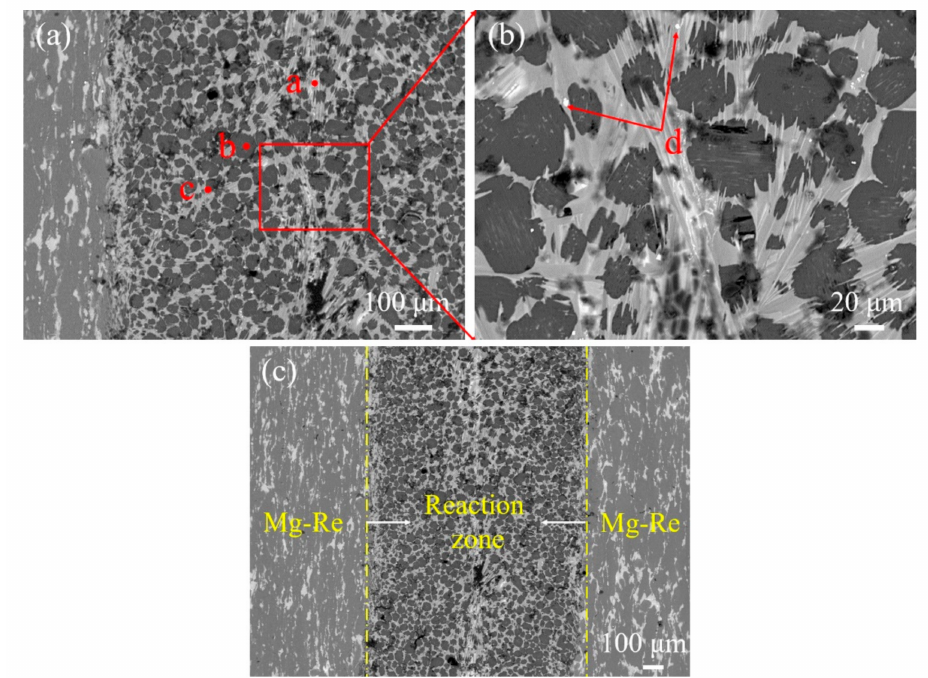
Figure 5. Microstructure of diffusion bonding joint at 440 ◦ C, 1500# for 30 min under 2 MPa. ( a ) the microstructure of the weld, ( b ) partial enlargement of a figure ( a ), ( c ) different zones at the